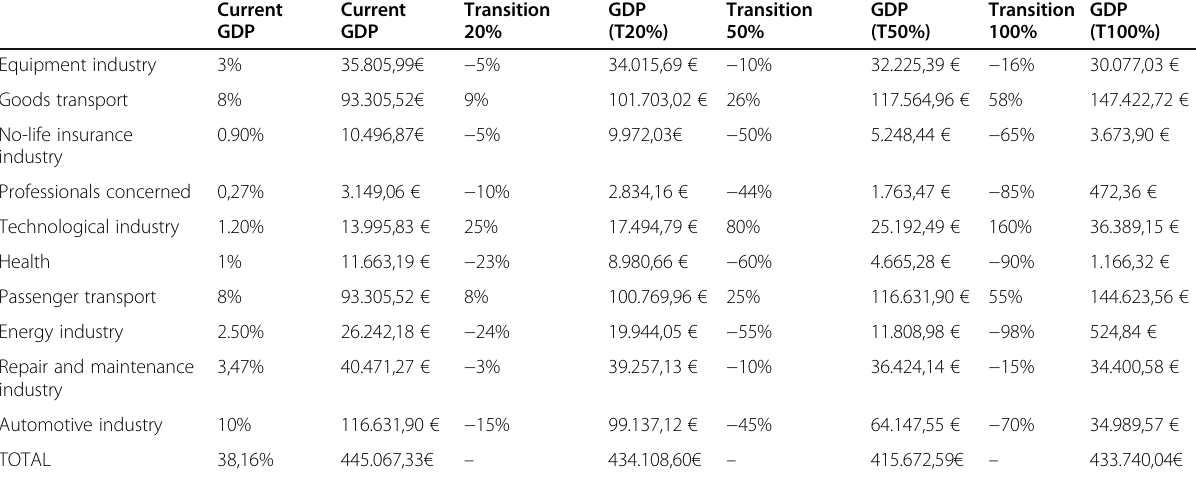
Table 2 GDP Forecast of all the industries analyzed along with this paper with the three scenarios proposed and their related GDP data in millions of euros